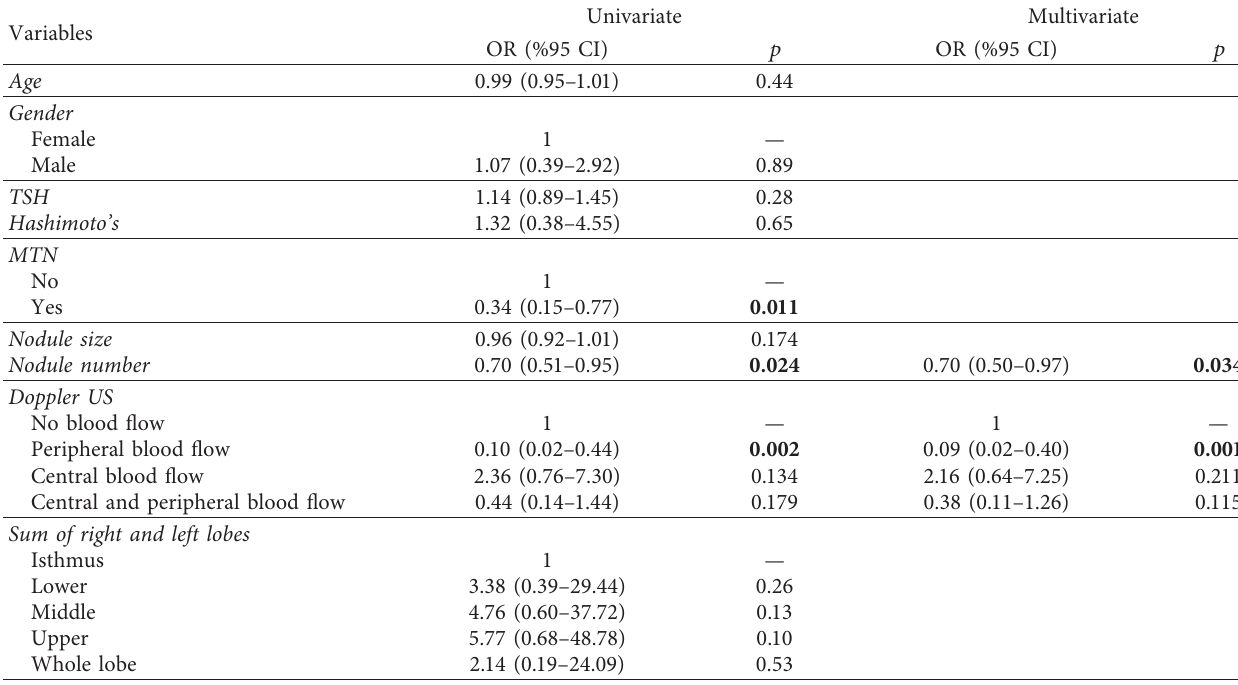
Table 7: Evaluation of risk factors affecting malignancy status for FNAB